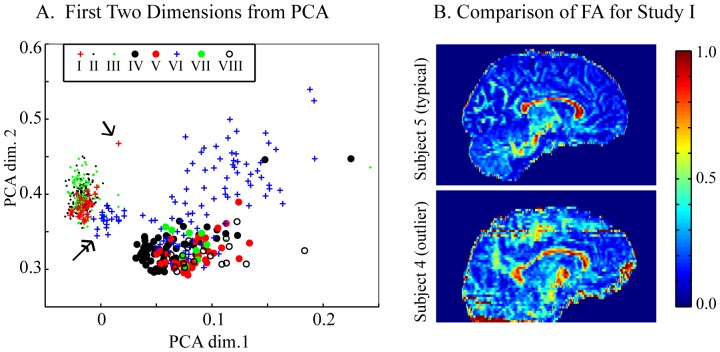
Statistical metrics stored by pipeline evaluated using PCA.Each of the 567 DTI datasets was characterized by a 112 element vector of stored outputs from the pipeline. PCA analysis was performed on the resulting data. (A) DTI dataset locations in the first two dimensions of the PCA analysis. Data is symbolized by study Roman numeral (
Table 1
). Single arrow points to a data quality outlier from study I; subject 3 in Figure 4 and in (B). A double headed arrow points to a cluster representing an isolated protocol sub-group from study VI. (B) FA maps from similar sagittal slice locations in two subjects from Study I. Subject 4 is the indicated outlier in (A) and subject 5 was selected from the center of the study I cluster seen in (A).